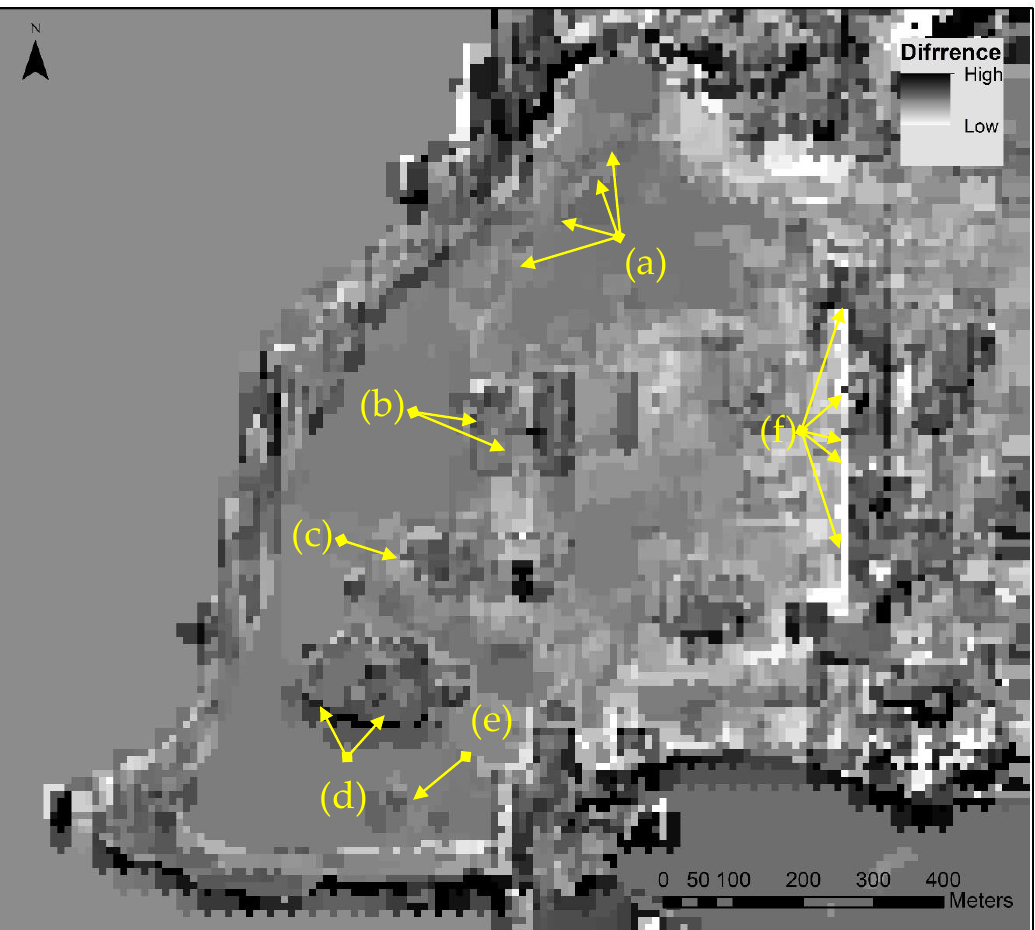
Figure 10. Difference of the segmentation image of the original Landsat 8 image and the fused Gram–Schmidt pansharpened image, at the scale factor 60. For the details of areas (a) to (f) refer to the text.